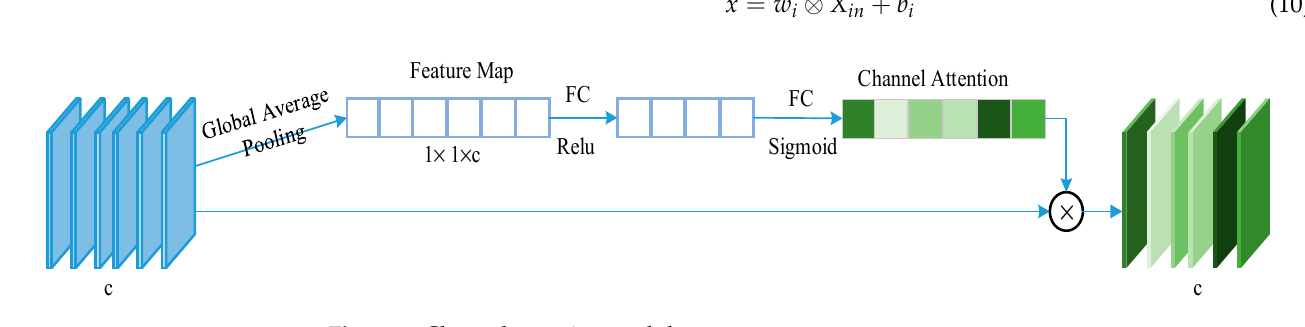
Figure 6. Channel attention module.